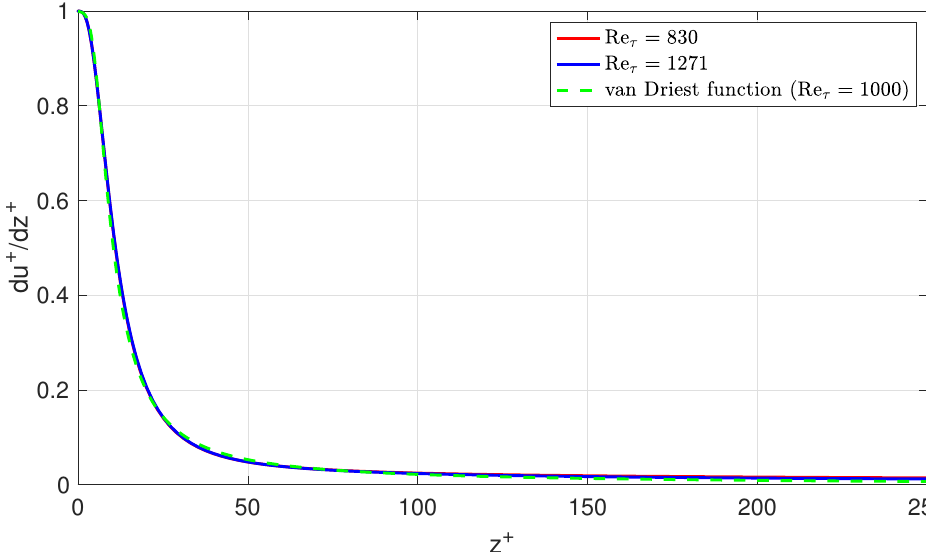
Figure 5. The non-dimensional velocity shear as a function of z + for the DNS of non-rotating BBL. The dashed green curve is the van Driest function with ζ = 26 and Re τ =1000 (Equation (10)).